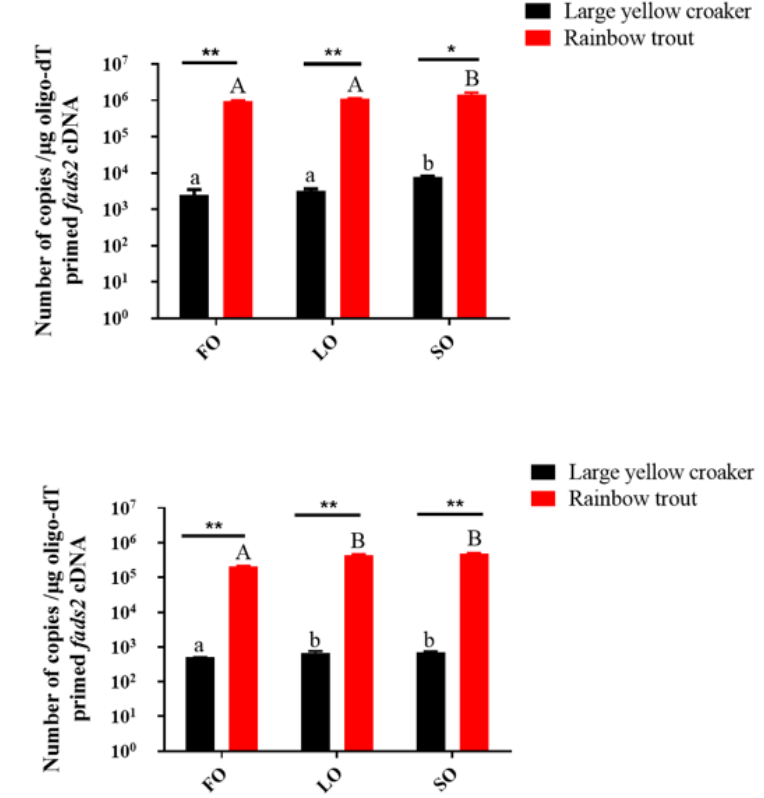
Figure 1. The absolute expression of fads2 in liver ( a ) and intestine ( b ) of large yellow croaker and rainbow trout. Values are presented as mean ± SEM ( n = 3). The “*” means a significant difference ( p < 0.05) and “**” means a highly significant difference ( p < 0.01). Bars without sharing a common letter are significantly different ( p < 0.05). FO: 100% fish oil as a lipid source in the diet. LO: 100% linseed oil as a lipid source in the diet. SO: 100% soybean oil as a lipid source in the diet.